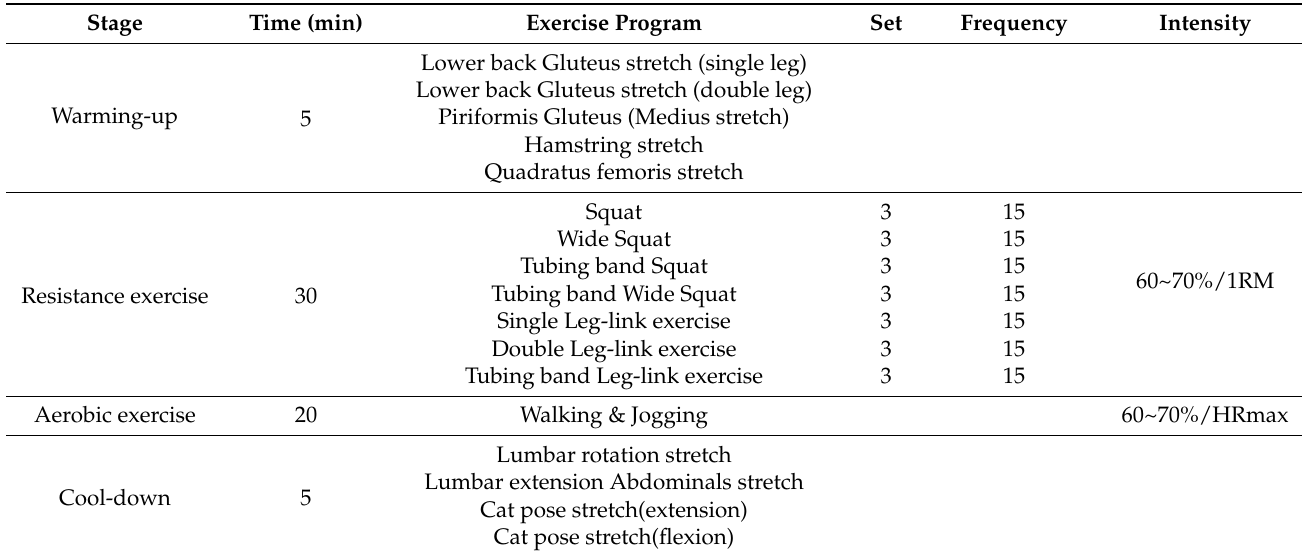
Table 1. Combined exercise training